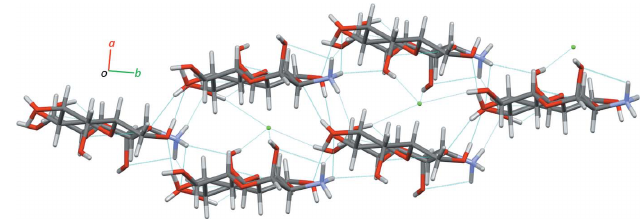
Figure 2 The molecular packing in ( I ) as viewed along the c axis. Hydrogen bonds are shown as cyan dotted